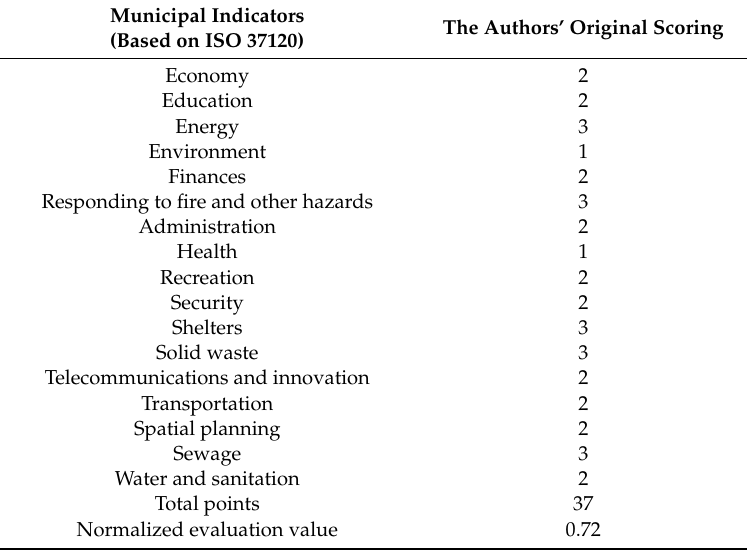
Table 4. Assessment of features of the quality of